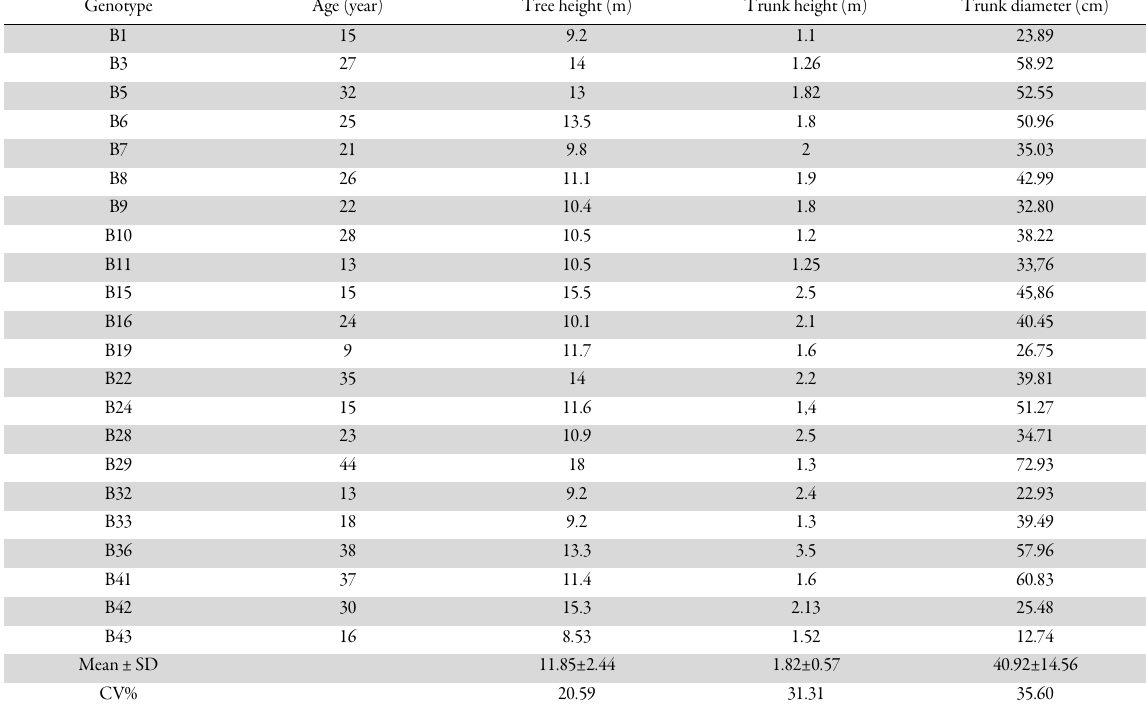
Table 1. Characteristics of growth elements in analysed genotypes